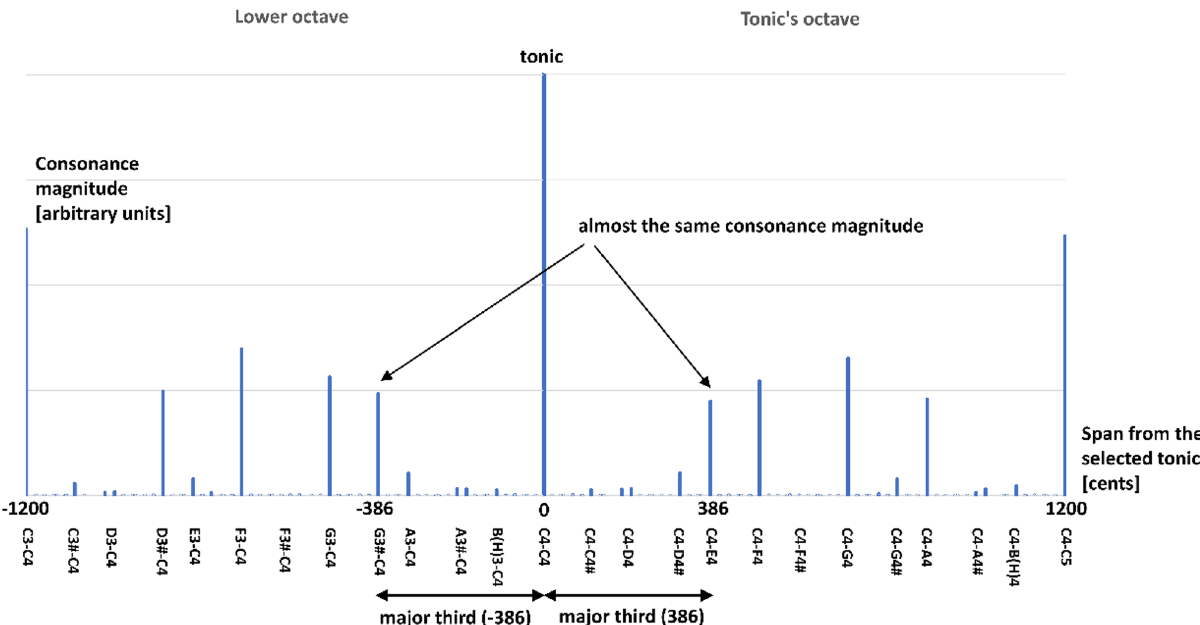
Figure 4. Symetry between the lower- and the tonic’s octave. The figure shows the synaptic weights (the consonance measure) of the emerged intervals, including the selected tonic (C4 in the example shown here) in the octave-span below and above the tonic. The symmetry of consonance between the C3–C4 octave tone (the lower) and the C4–C5 (the upper) is evident. Although the graph shows that the tone G3# forms the minor sixth interval C3–G3# (the minor sixth is an inversion of the major third) may raise appearance about the equivalence of the intervals with their inversion, that is misleading—the intervals’ magnitudes shown on the left portion of the graph is the major third in the key of G3#. The horizontal axis represents the interval span in cents. The vertical axis represents the synaptic weights (the consonance measure) in arbitrary units. For this graphic, the magnitude of the tonic is artificially lowered, so the rest of the intervals are noticeable.